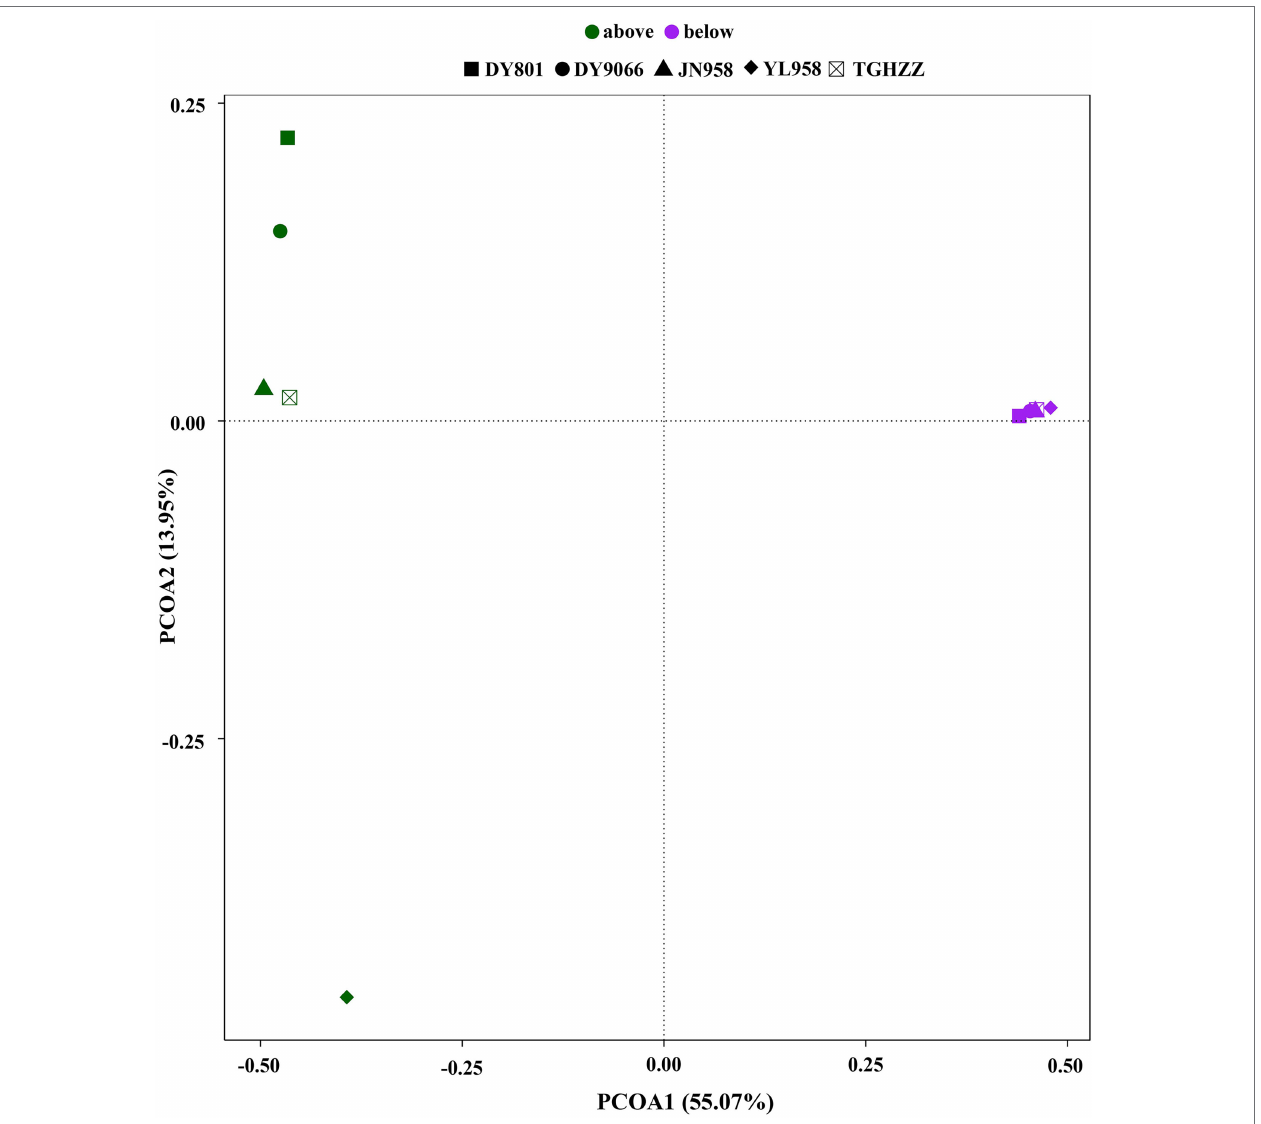
FIGURE 5 | Principal component analysis plot of partitions above and below neutral model predictions based on Jaccard index calculated from the presence/ absence of